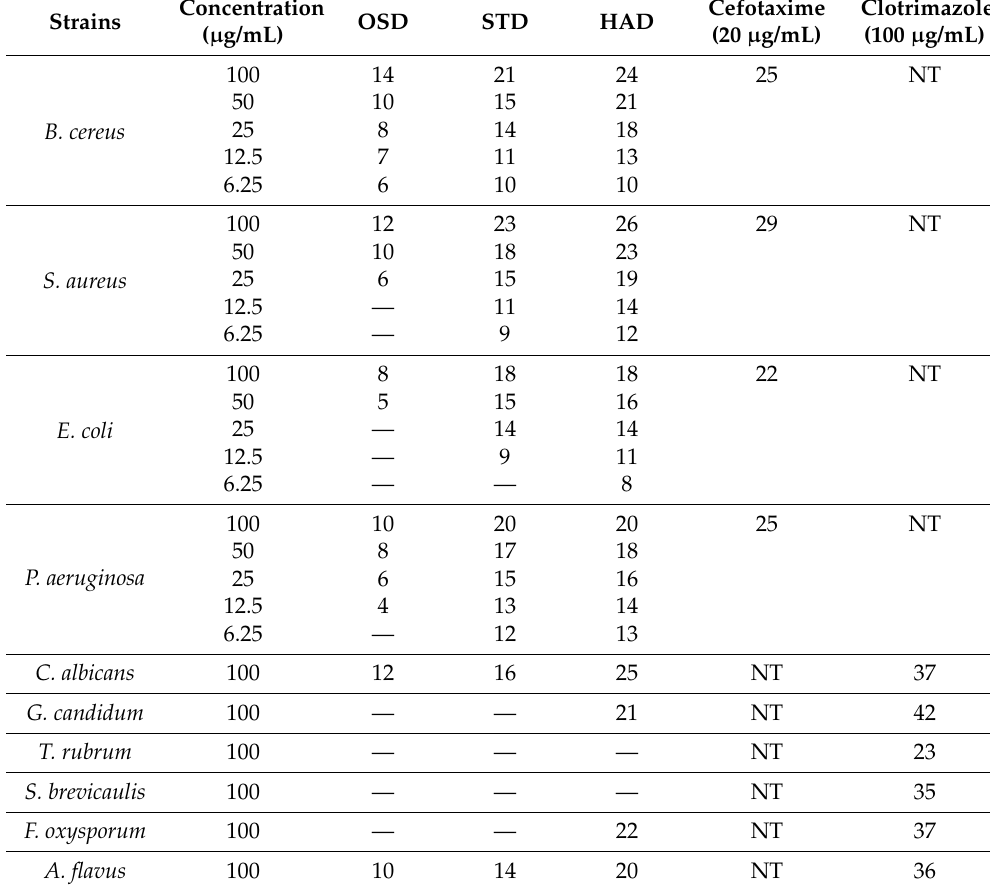
Table 3. Inhibition zone of antimicrobial and antifungal activity of ginger, dried with different methods.